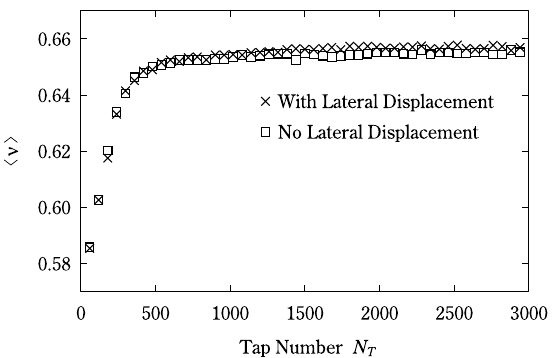
Table 1. Fitting parameters for hyperbolic tangent law